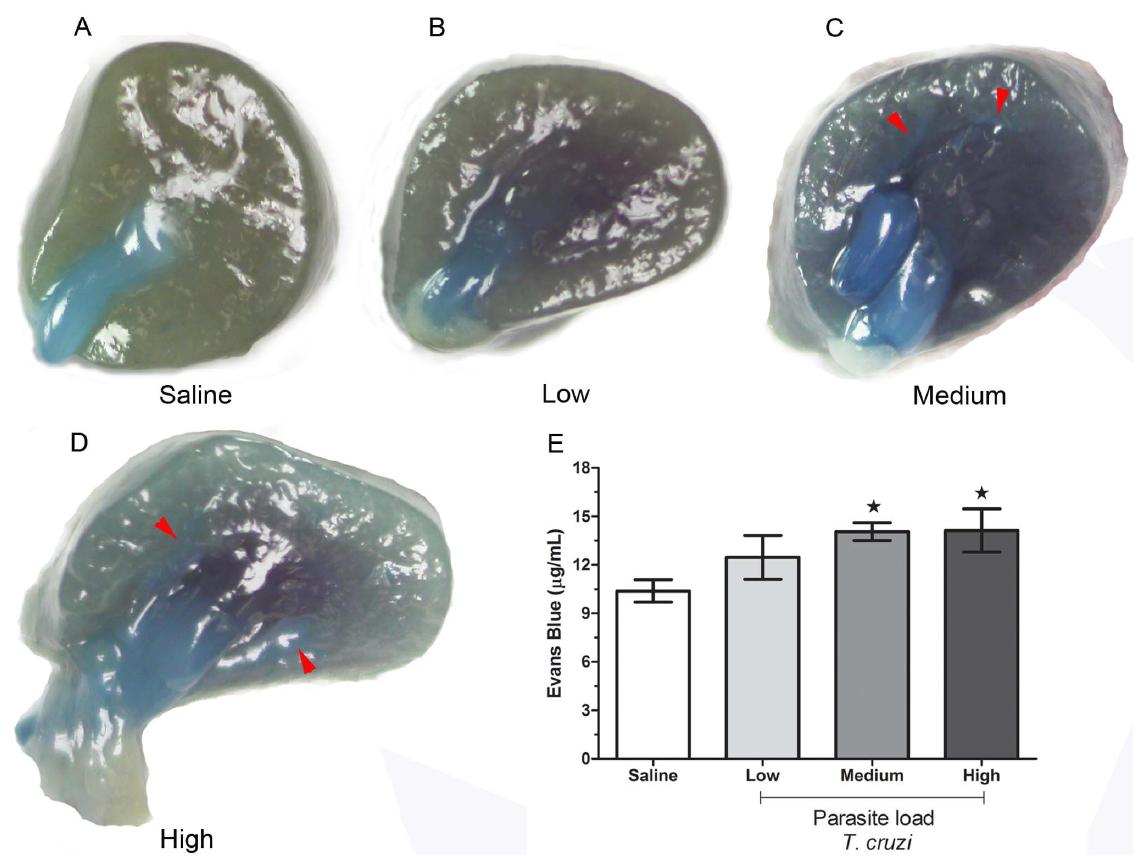
Figure 7. Effect of T.cruzi parasite loads on vascular permeability in the kidney tissue. C57BL/6 mice were challenged with low, medium and high loads of trypomastigotes and at 9 day post-infection, the accumulation of Evans Blue in the renal tissues was assessed. In A–D, a representative image of Evans Blue accumulation in the kidney from each group is demonstrated. E shows the mean percentage 6 SEM of Evans Blue accumulation in the renal parenchyma. *p # 0.05 indicates a significant difference when mice from the medium and highly infected groups were compared to the uninfected control mice.